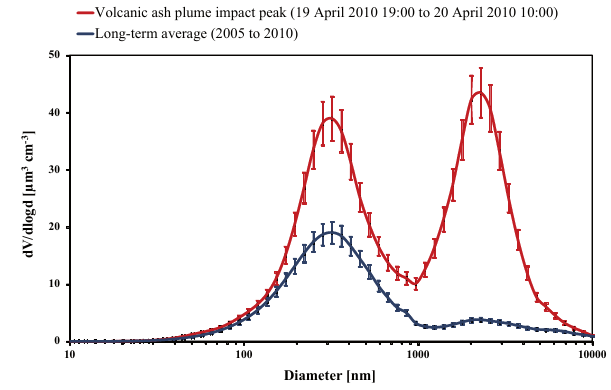
Fig. 3. Hourly average particle volume size distributions during the volcanic ash plume impact in comparison to the long-term average of the years 2005 to 2010 at the University of Applied Sciences in Augsburg, Germany. The error bars represent ± 10%.